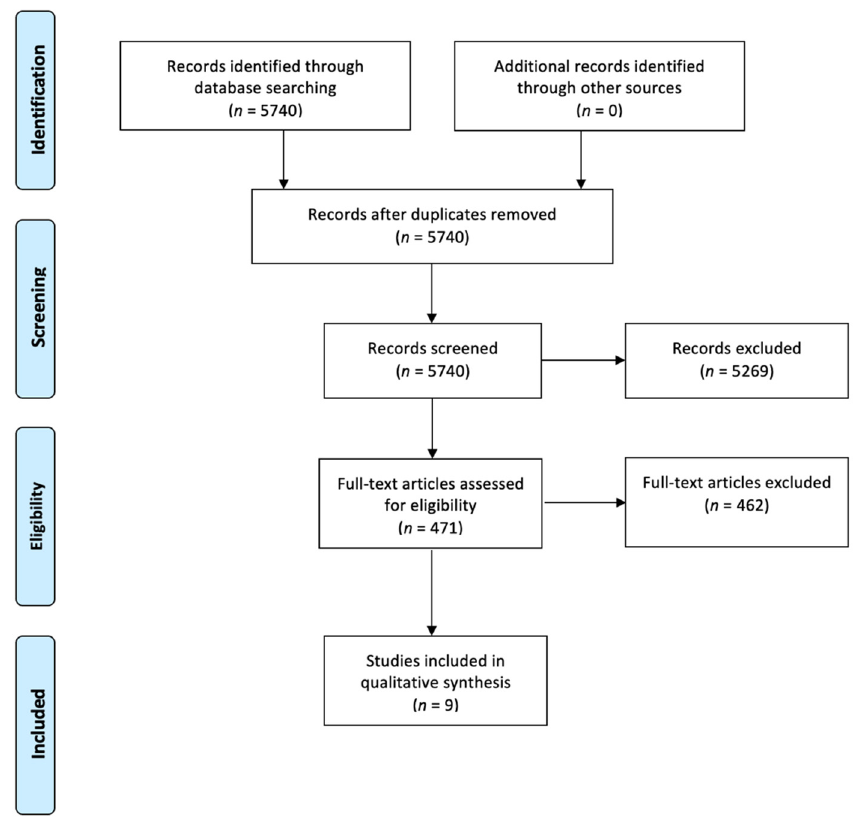
Figure 1. Study flow chart phases of the systematic review according to the Preferred Reporting Items for Systematic Reviews and Meta-Analyses (PRISMA) flow diagram guidelines.